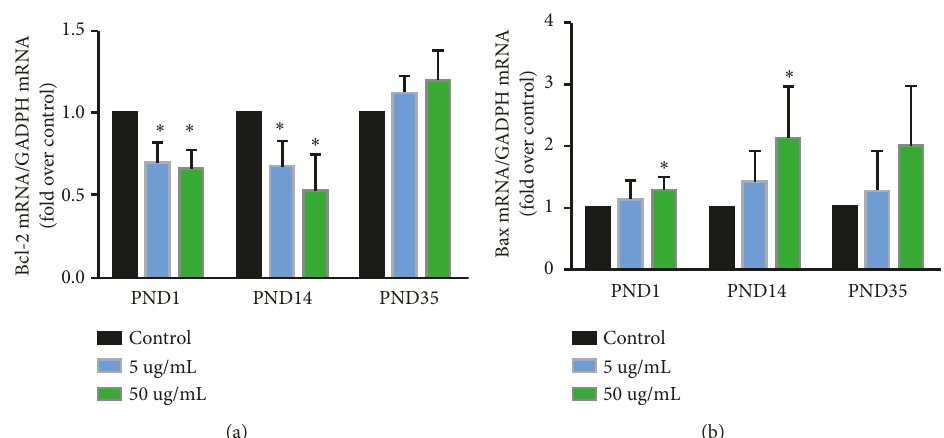
Figure 3: Real-time PCR was conducted on the mRNA levels of Bcl-2 (a) and Bax (b) . Data represent mean ± SD. N=3 per treatment group, with each n representing a different litter from a different female. The ∗ indicates a significant difference compared to control at P < 0.05.